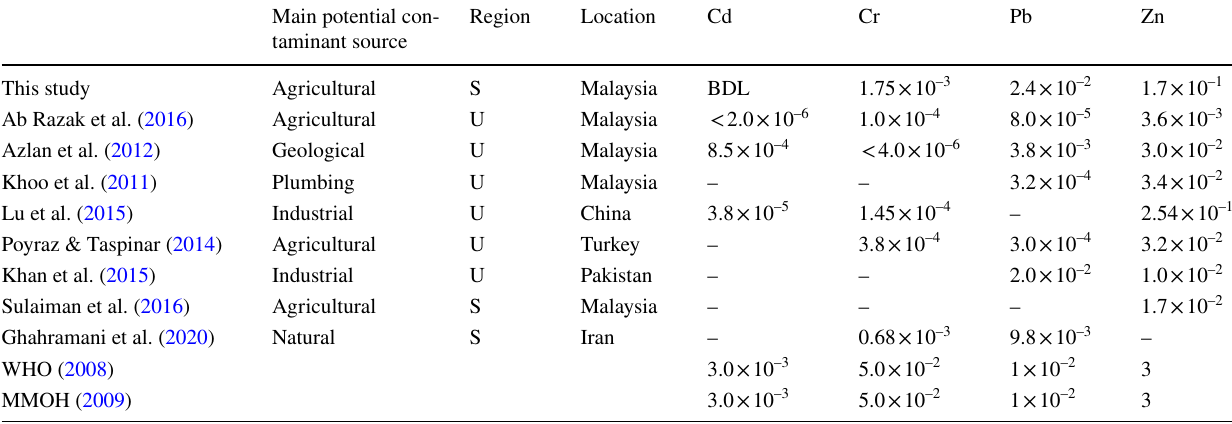
Table 2 Comparison between the metal concentrations in drinking water (mg/L) in this study and selected previous studies